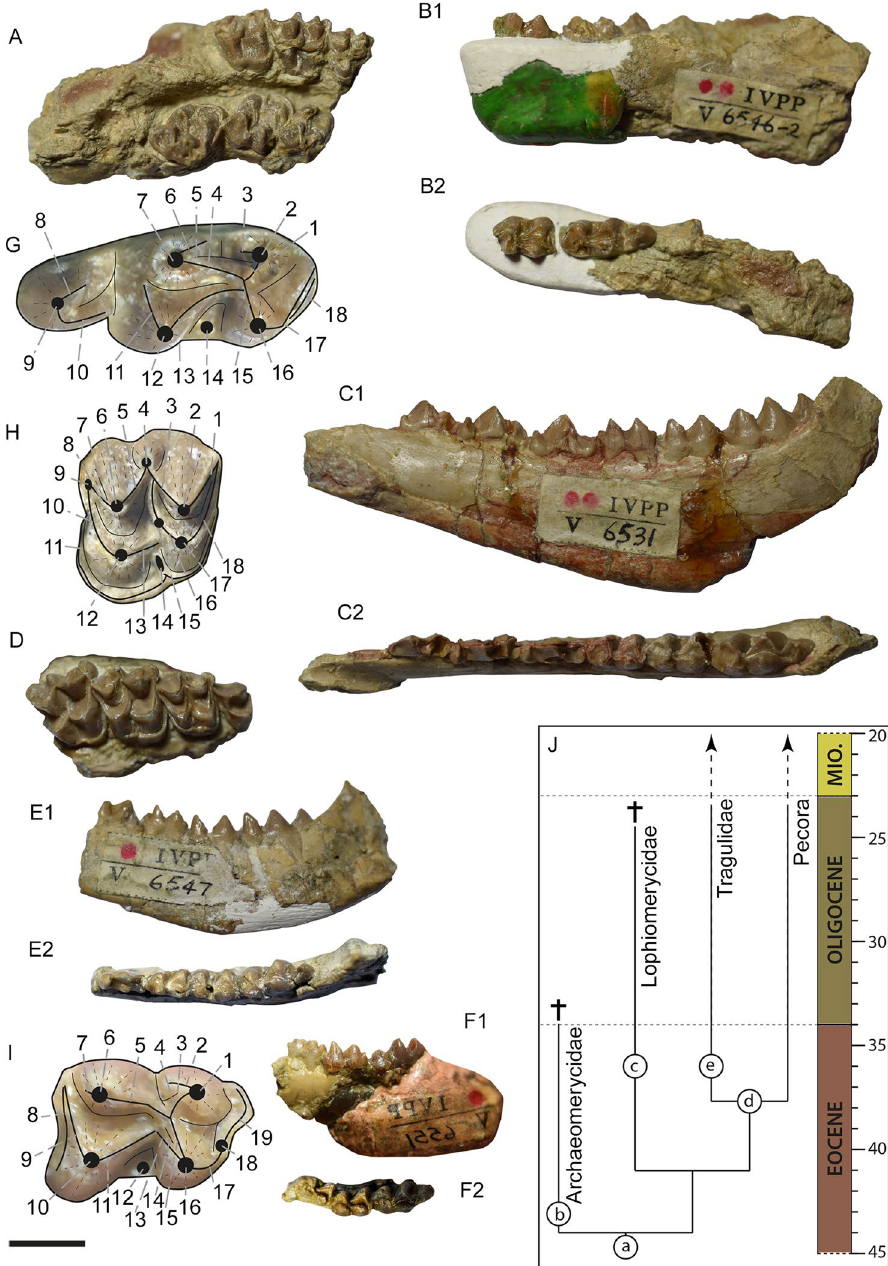
Figure 1. Dentition of Krabimeryx gracilis nov. comb. (Miao, 1982) 20 ( A , B , G , H ), Chiyoumeryx nov. gen. shinaoensis (Miao, 1982) 20 ( C , D ), Chiyoumeryx nov. gen. flavimperatoris nov. sp. ( E ) and Iberomeryx miaoi nov. sp. ( F – I ). Krabimeryx gracilis nov. comb. (Miao, 1982) 20 : ( A ) IVPP V 6546-1 (holotype), partial skull with right and left M1–M3; ( B ) IVPP V 6546-2 (holotype), right fragmented mandible with m2–m3. Chiyoumeryx nov. gen. shinaoensis (Miao, 1982) 20 : ( C ) IVPP V 6531 (holotype), right mandible with p2–m3 and tooth socket of p1; ( D ) IVPP V 6532 (paratype), right fragmented maxillary with P4-M3. Chiyoumeryx nov. gen. flavimperatoris nov. sp.: ( E ) IVPP V 6547 (holotype), right mandible with p4–m3; Iberomeryx miaoi nov. sp.: ( F ) IVPP V 6551 (holotype), left mandible with m1–m3 (mirrored); ( G ) lower molar Lophiomerycidae dental nomenclature (based on the m3 of IVPP 6546-2): 1 internal postmetacristid, 2 metaconid, 3 external postmetacristid, 4 internal preentocristid, 5 entoconidian groove, 6 external preentocristid, 7 entoconid, 8 posthypoconulidcristid, 9 hypoconulid, 10 prehypoconuldicristid, 11 posthypocristid, 12 hypoconid, 13 prehypocristid, 14 ectostylid, 15 postprotocristid, 16 protoconid, 17 preprotocristid, 18 anterior cingulid; ( H ) upper